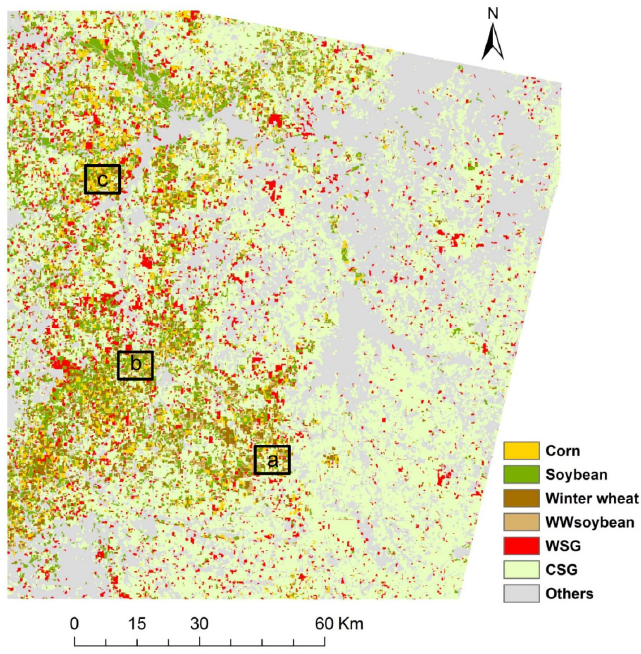
Figure 8. The classification results using object-based method. Rectangles named ( a ), ( b ), and ( c ) are three subset areas for the demonstrative comparison between our classification and CDL product. Table 4. The error matrix for the object-based classifications (%).